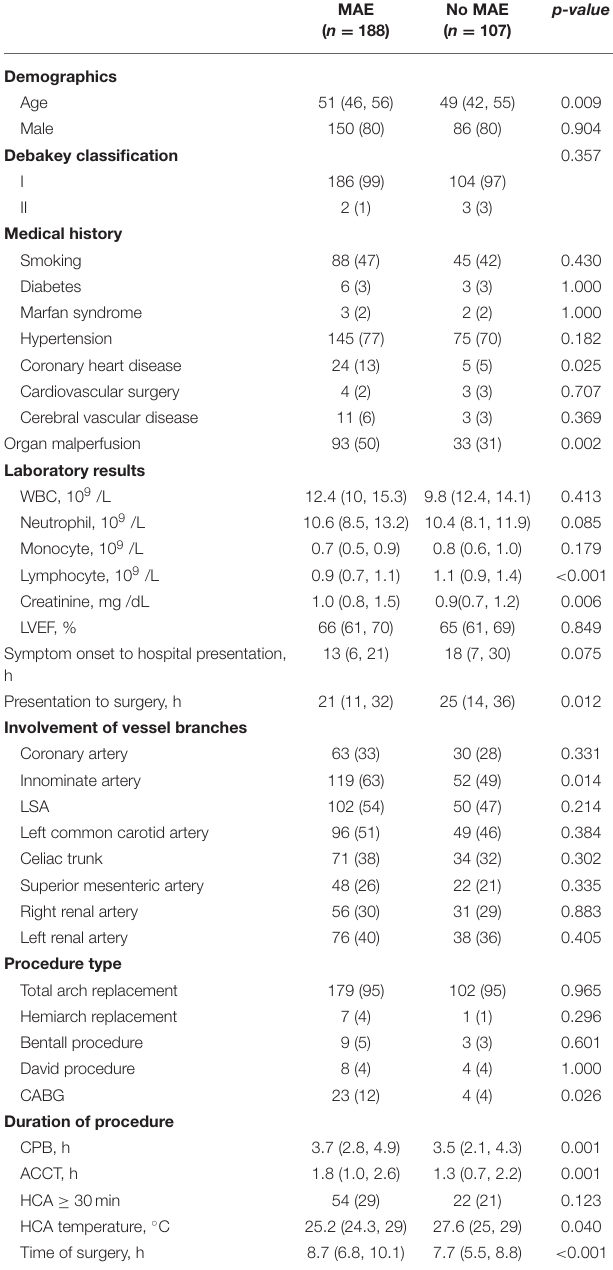
TABLE 3 | Baseline characteristics of patients with MAE and no MAE in retrospective cohort.